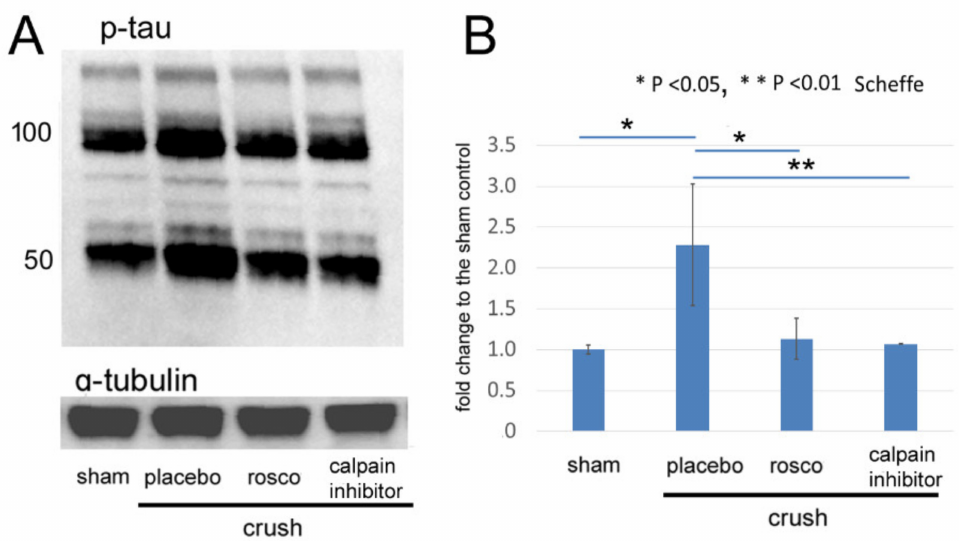
Figure 3. Western blots for phosphorylated tau in the retina after ONC and effects of roscovitine and calpain inhibitor on the degree of expression. ( A ): Representative protein bands of phosphorylated (ser 396) tau in extracts from the retina on day 3 after ONC. α -tubulin was used as an internal control. ( B ): Phosphorylated (ser 396) tau levels in 50-kDa bands are shown as fold changes (means ± SD) relative to the sham control. The levels significantly increased in the retina after ONC (placebo) from the sham control, while roscovitine and calpain inhibitor reduced the degree of increase. (* p < 0.05, ** p < 0.01, Scheffe; n = 3 for each